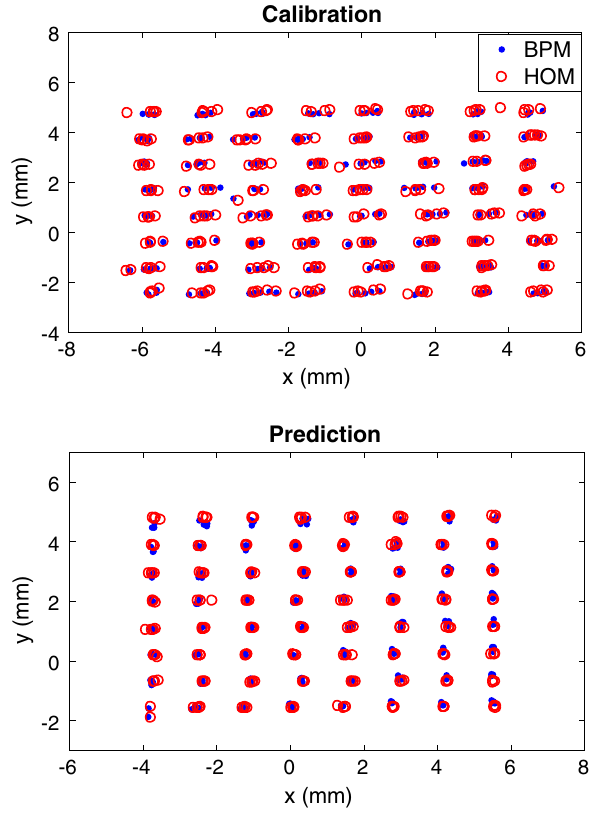
FIG. 14. HOMBPM calibration in April 2018 (top) and prediction in January 2019 (bottom) based on signal fitting method in cavity four. The RMS error between the blue and red positions is 0.10 mm in x and 0.06 mm in y for the calibration, 0.09 mm in x and 0.08 mm in y for the